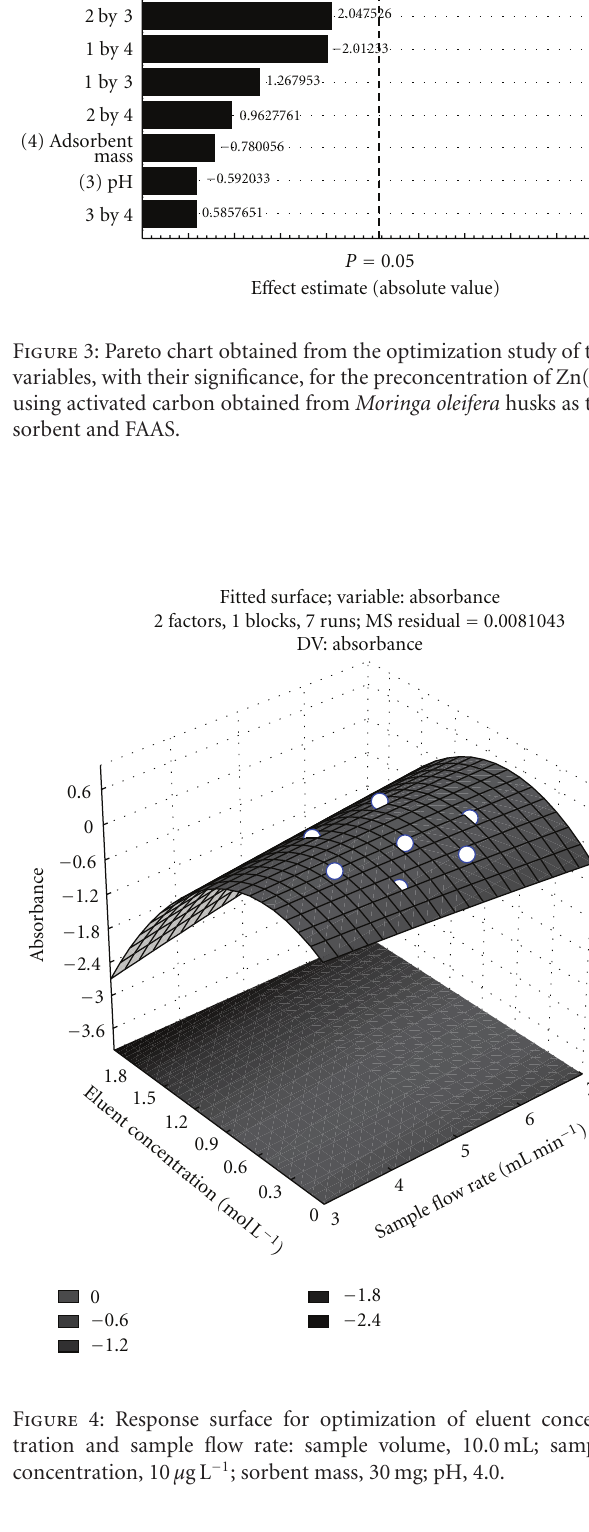
Table 1: Conditions for preconcentration of zinc and analytical response for the study of multivariate optimization using SPE with detection by FAAS.